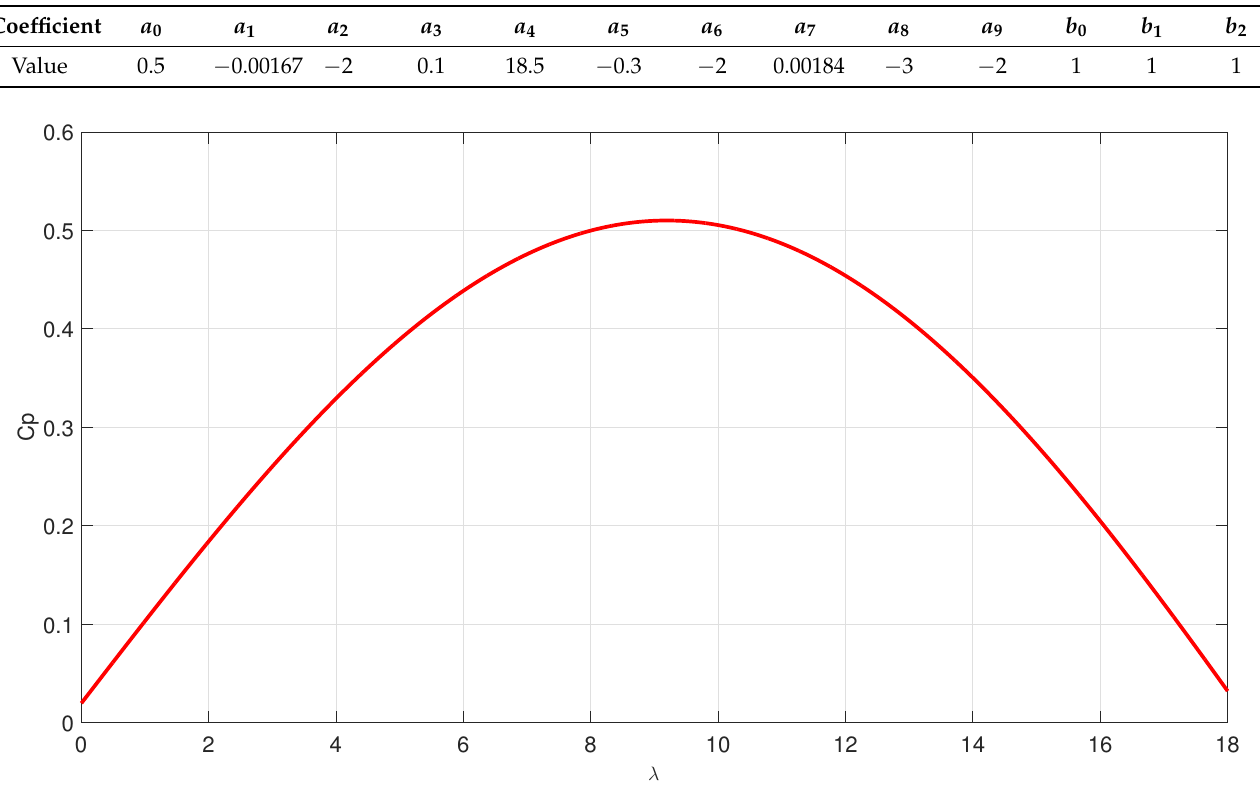
Figure 1. C p curve used in the project as a function of tip speed